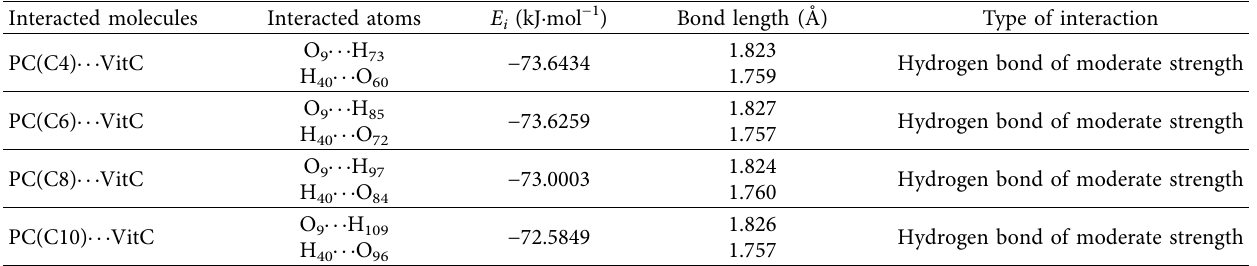
Table 4: Phospholipid and vitamin C interaction parameters. Interacted molecules